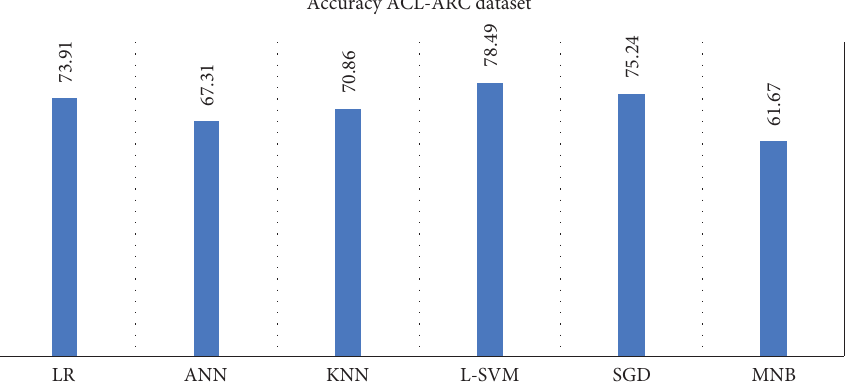
Figure 6: Accuracy of classifiers using the ACL-ARC dataset.